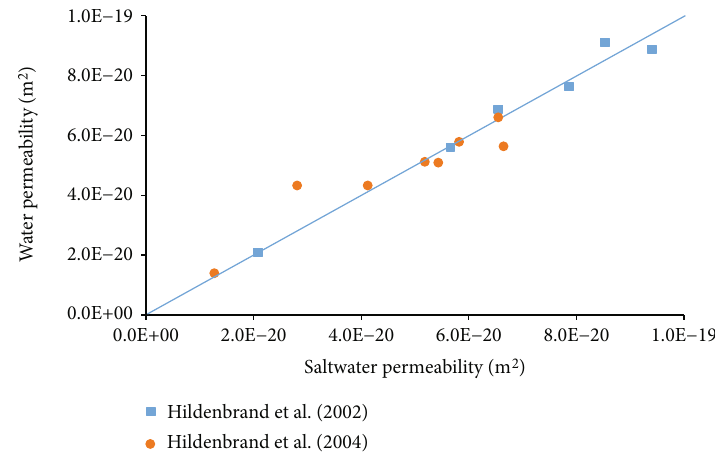
Figure 2: Relationship between saltwater permeability and water